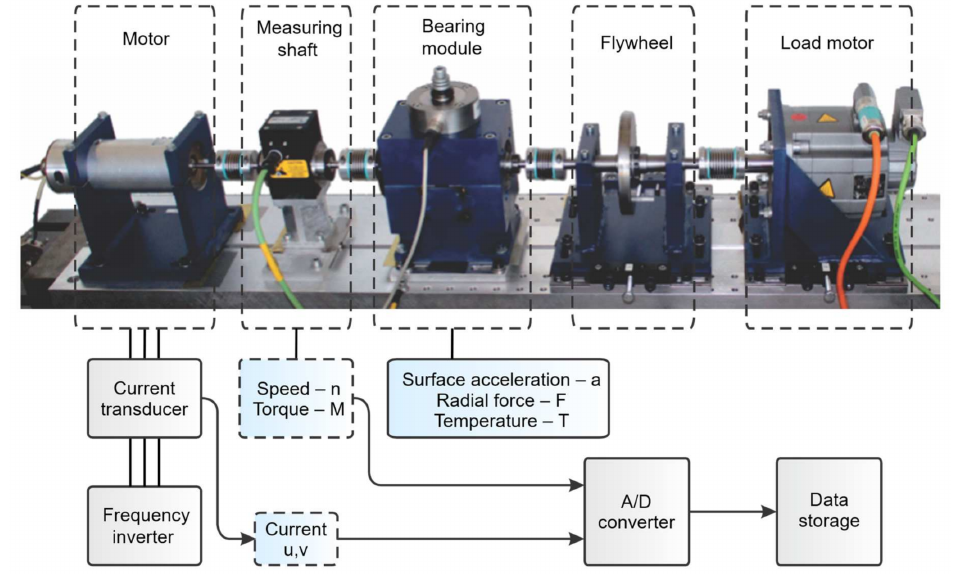
Figure 4. Modular test rig used for data